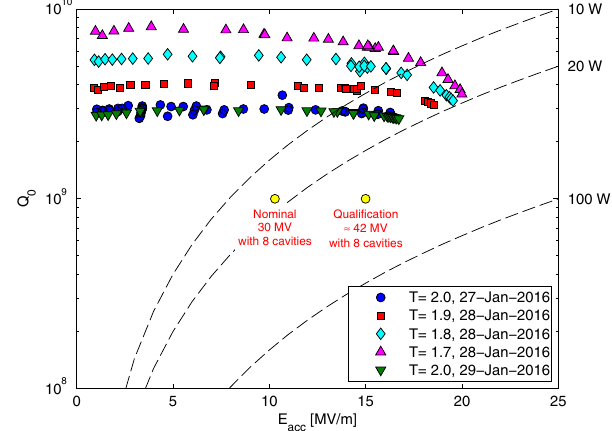
FIG. 11. Power rises ( Q 0 vs E a cc plots) at different temper- atures for cavity